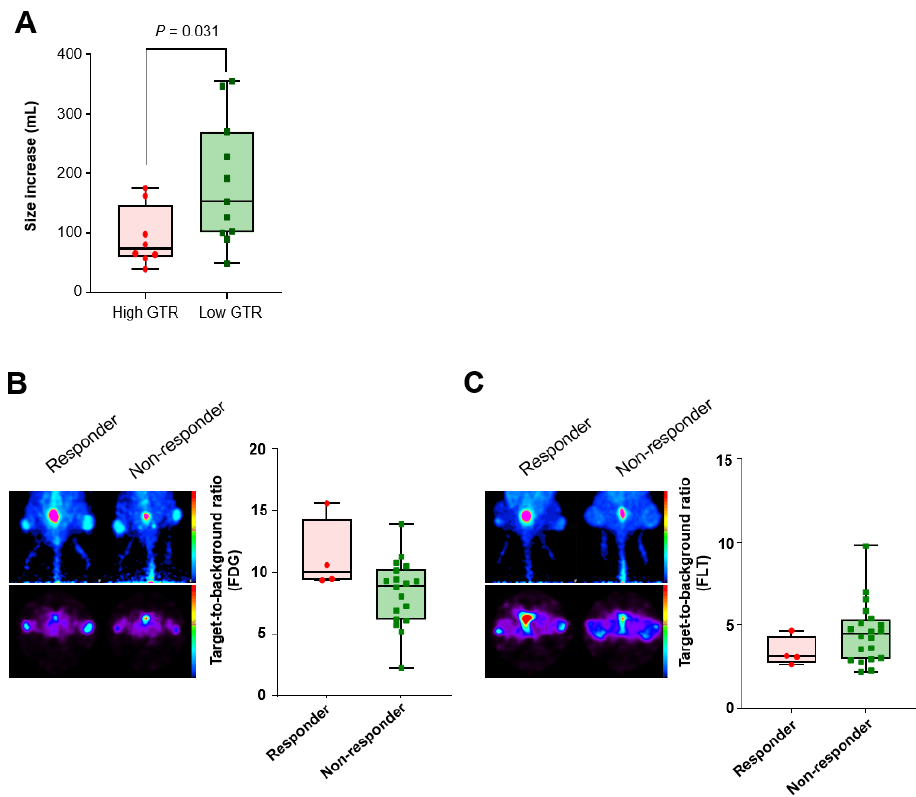
Figure 3. Comparison of tumor growth according to the image findings. ( A ) When the ICI treatment group was classified by the GTR with a cutoff value of 1.50, high ‐ GTR tumors showed significantly lower growth than low ‐ GTR tumors ( p = 0.0310). On day 14, TBR on 18 F ‐ FDG PET images was rela ‐ tively higher in responders than non ‐ responders ( B ), whereas TBR on 18 F ‐ FLT PET images was rel ‐ atively lower in responders than non ‐ responders ( C ). relatively higher in responders than non-responders ( B ), whereas TBR on 18 F-FLT PET images was relatively lower in responders than non-responders ( C